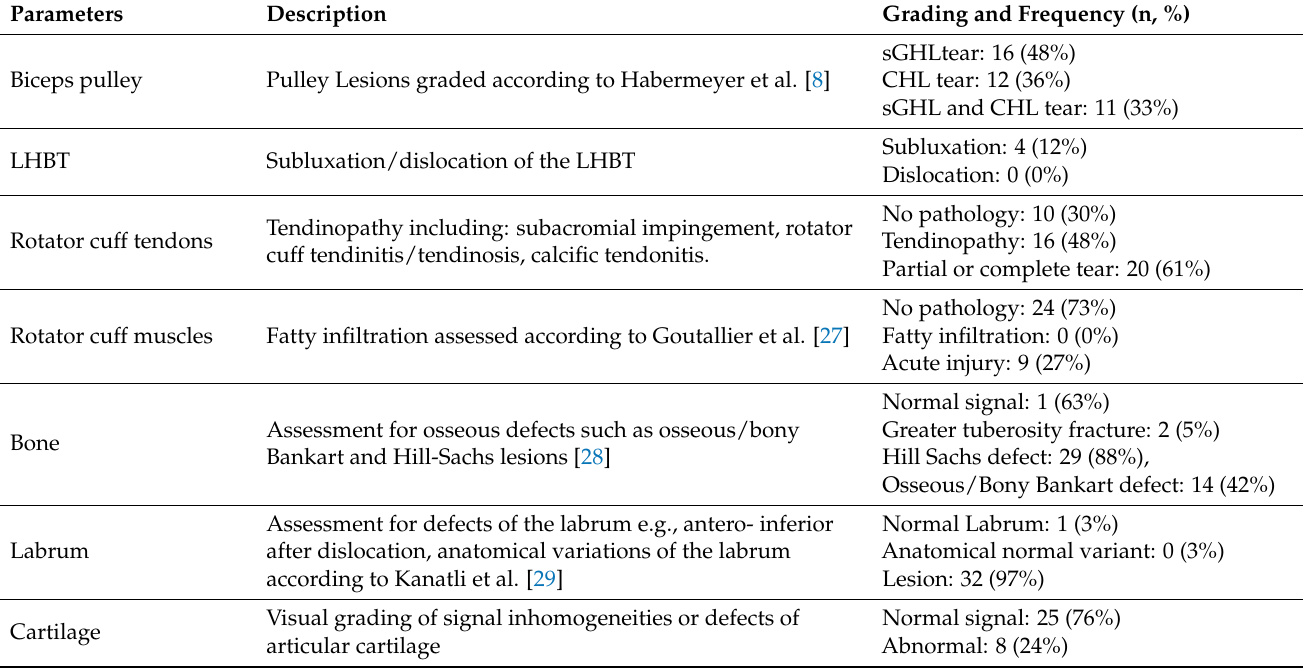
Figure 2. ( A ) Transversal IM-weighted TSE sequence with spectral fat saturation of a 45-year-old patient after traumatic shoulder dislocation with antero-inferior labral lesion and concomitant medial subluxation of the LHBT (white arrow) due an insufficient biceps pulley and a partial SSC tendon tear. ( B ) Sagittal IM-weighted TSE sequence with spectral fat saturation. Pulley lesion in a 39-year-old patient after traumatic anterior shoulder dislocation with tear of the sGHL and CHL. Note the displacement of the LHBT (white arrow) as well as the tendinopathic changes which might be due to preexisting degenerative changes. Table 2. Assessed pathologies in patients with traumatic dislocations of the